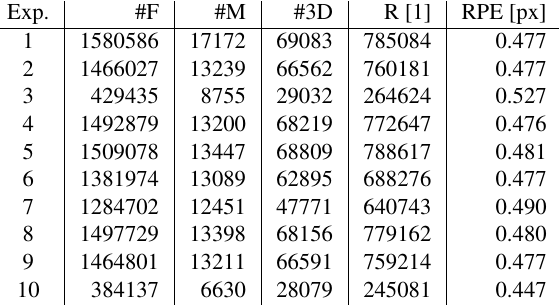
Table 1. Dataset statistics with number of features (#F), number of matches (#M), number of 3D points (#3D), redundancy (R) and mean reprojection error of all feature points (RPE). #3D, R and RPE are averaged across all test runs of each